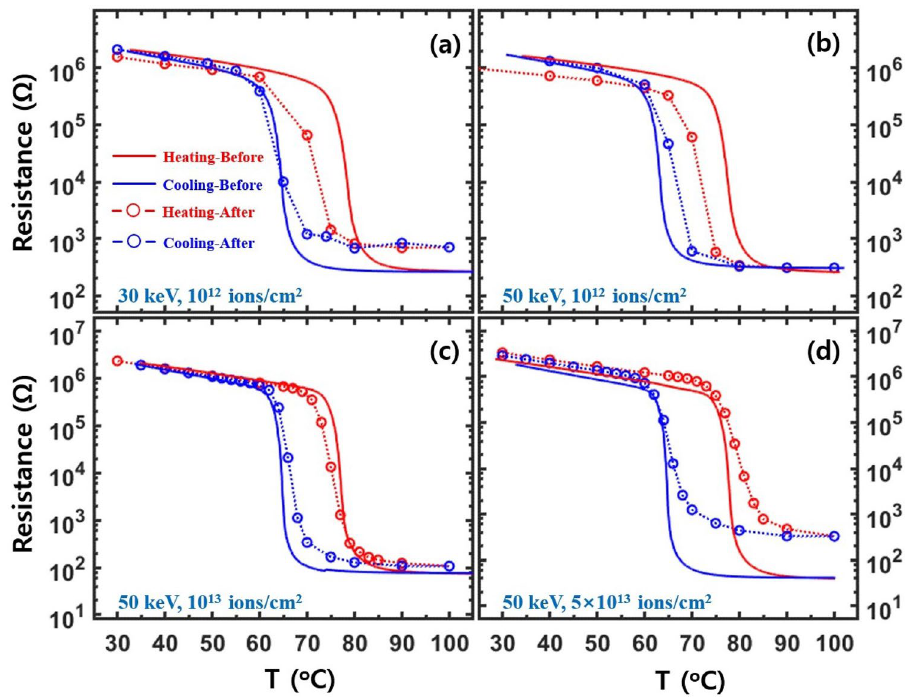
Figure 1. Temperature-dependent electrical resistance for Cr-VO 2 films with a Cr ion energy and a flux of ( a ) 30 keV and 10 12 ions/cm 2 , ( b ) 50 keV and 10 12 ions/cm 2 , ( c ) 50 keV and 10 13 ions/cm 2 , and ( d ) 50 keV and 5 × 10 13 ions/cm 2 , respectively. Solid lines and circles are the resistances for the same Cr-VO 2 film before and after Cr-ion implantation, respectively. XAFS was simultaneously measured at the temperatures of the circles. Red and blue colors indicate the resistance for heating and cooling processes, respectively. The dotted lines are a guide for the